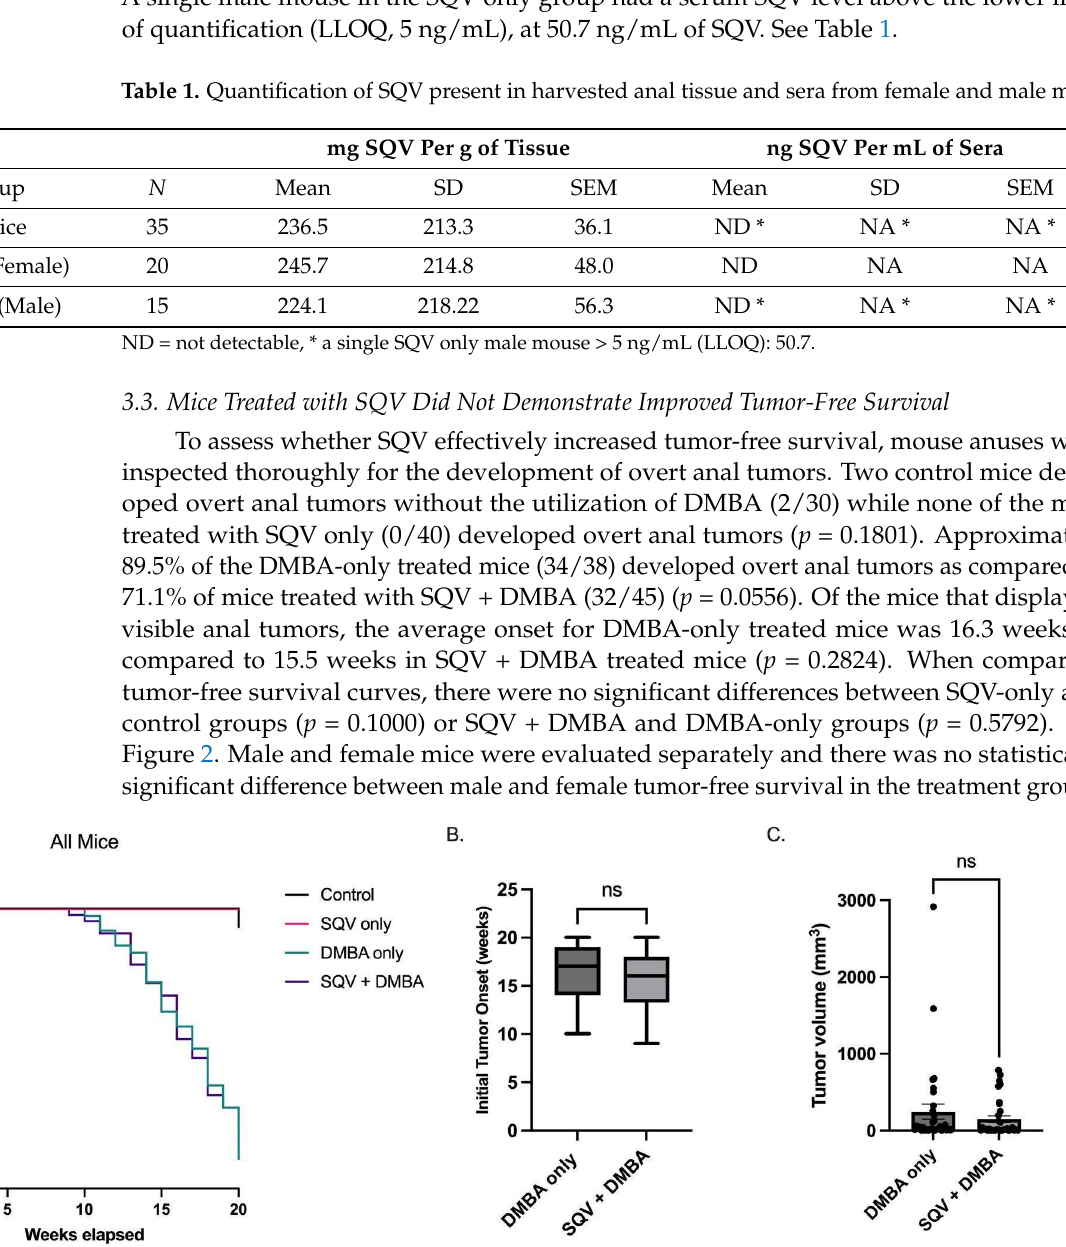
Table 1. Quantification of SQV present in harvested anal tissue and sera from female and male